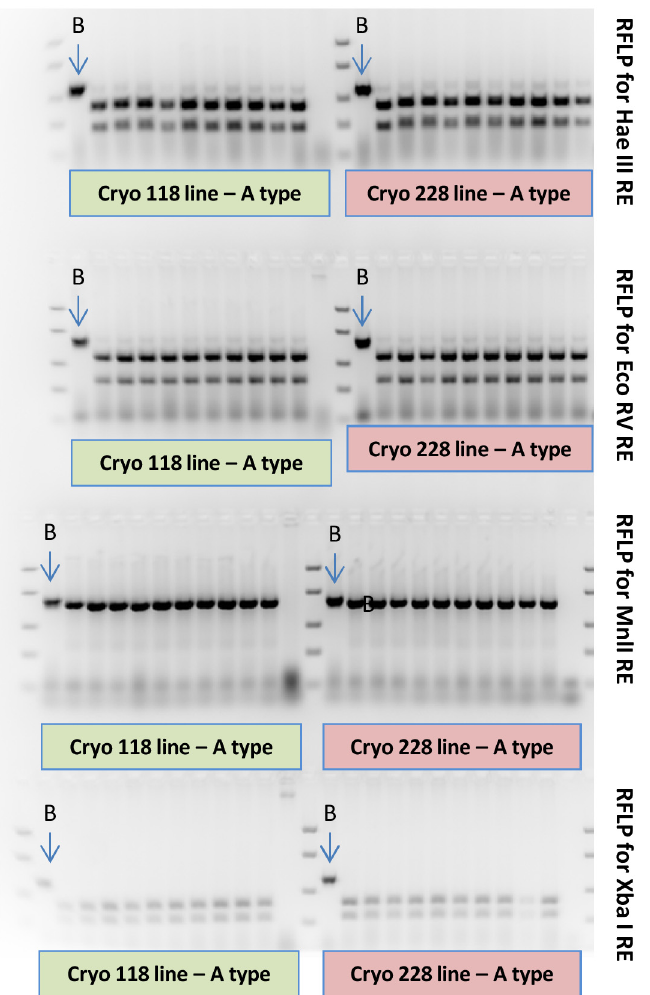
Fig 5. Test for the presence of RFLP markers identified for the original line before cryopreservation procedure. All flies derived from the Vienna 8 strain exhibit the expected AAAA haplotype. As a control, a fly belonging to the BBBB haplotype was included in the analysis (see 1st lane next to the marker). As a DNA marker, the FastRuler Low Range DNA Ladder was included in the electrophoresis.